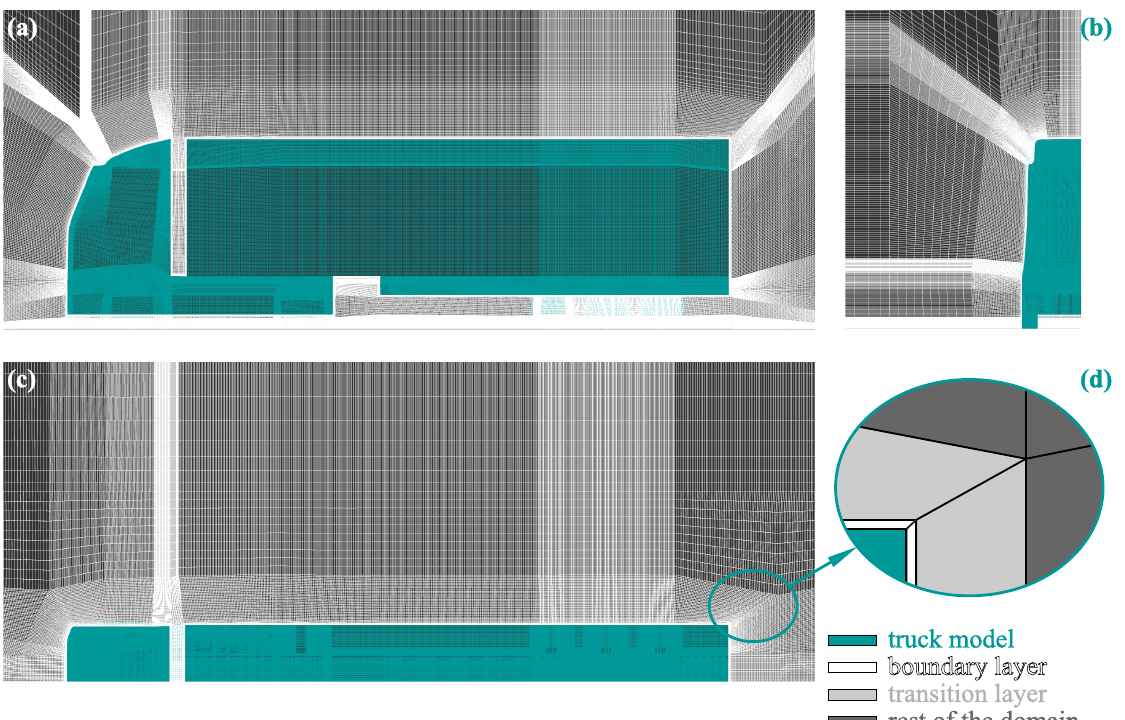
Figure 6. Discretization of single truck block—3D model. View from: ( a ) side, ( b ) front, and ( c ) top of the tunnel. ( d ) Schematic of grid layers near the